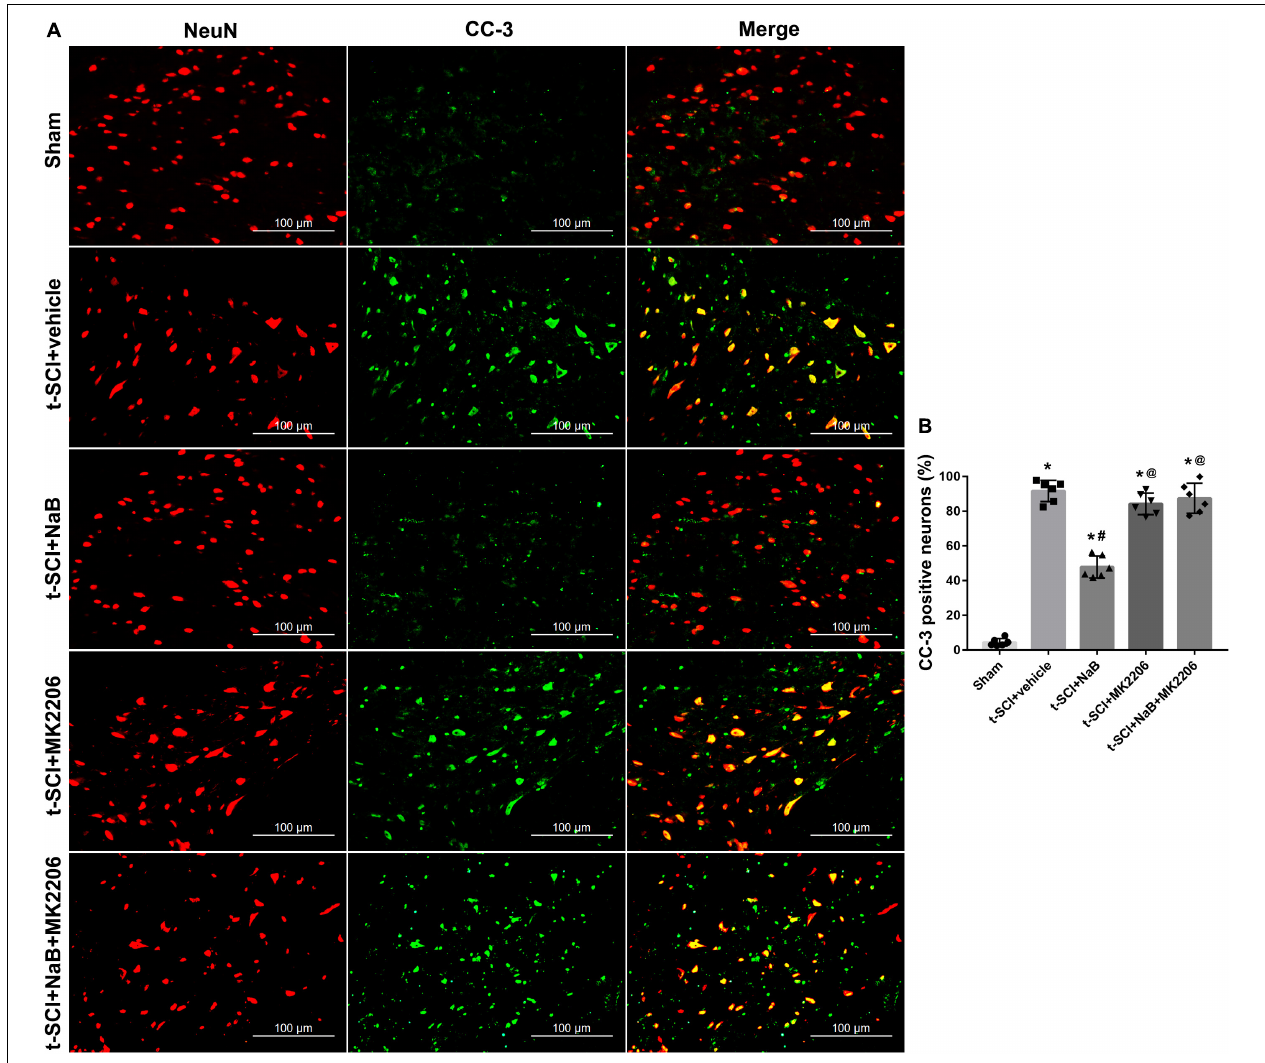
FIGURE 10 | Representative IF staining micrographs showing the proportion of CC-3-positive neurons in each group at 24 h post-injury. The proportion of CC-3-positive neurons was significantly increased after t-SCI. NaB treatment significantly decreased the proportion of CC-3-positive neurons; this effect was reversed by treatment with MK2206. Administration of MK2206 alone did not significantly increase the proportion of CC-3-positive neurons (A,B) . N = 6 for each group. Data is expressed as mean ± SD and analyzed by one-way ANOVA and Bonferroni’s post hoc multiple comparisons test. ∗ p < 0.05 versus control; # p < 0.05 versus injury; @ p < 0.05 versus injury +